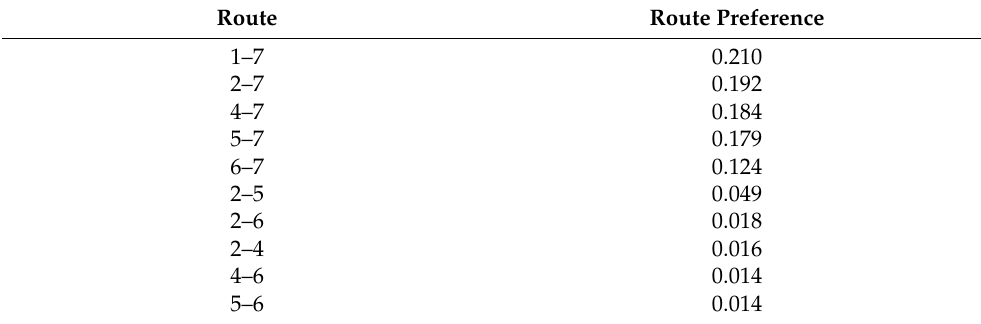
Table 2. Results of the